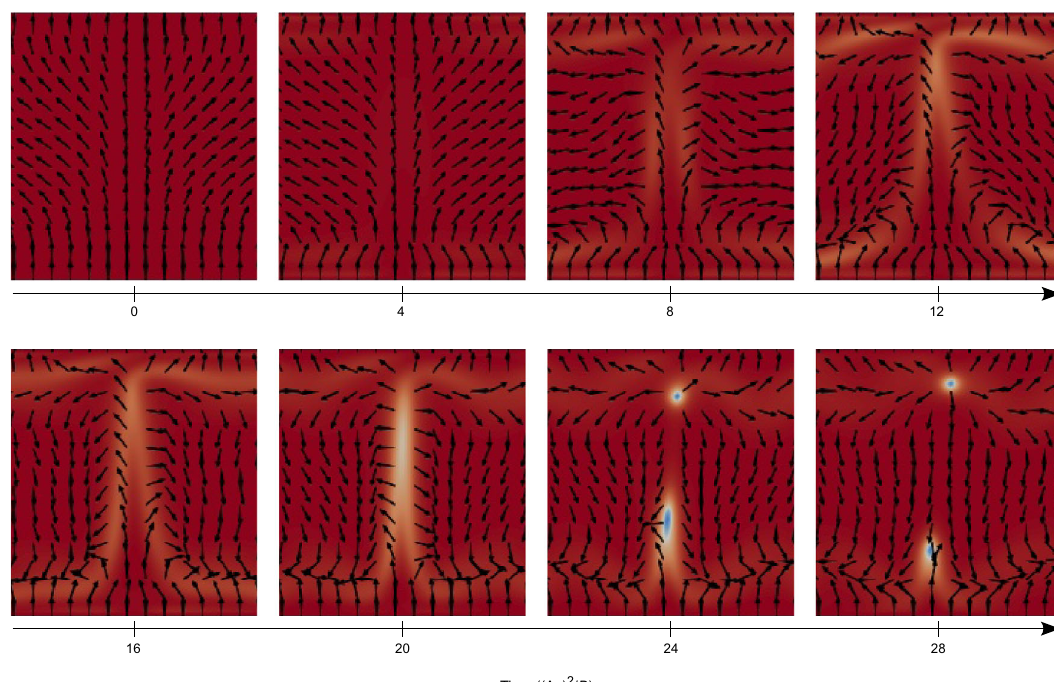
Fig. 8 | Generation oftopologicaldefect +1and − 1 pair intime as caused bythe irregular-chaotic fl owathighRanumber. Increased localdriving (concentration of photoinitiator) generates stronger material fl ow which in turn deforms the nematic orientational order until a defect pair is produced, relieving some of the